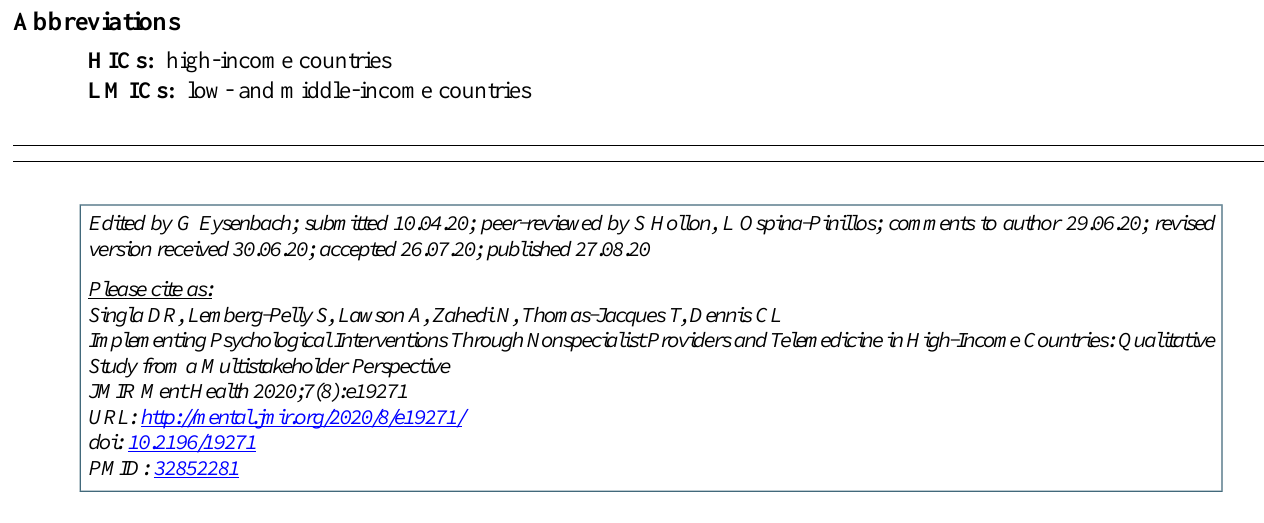
HICs: high-income